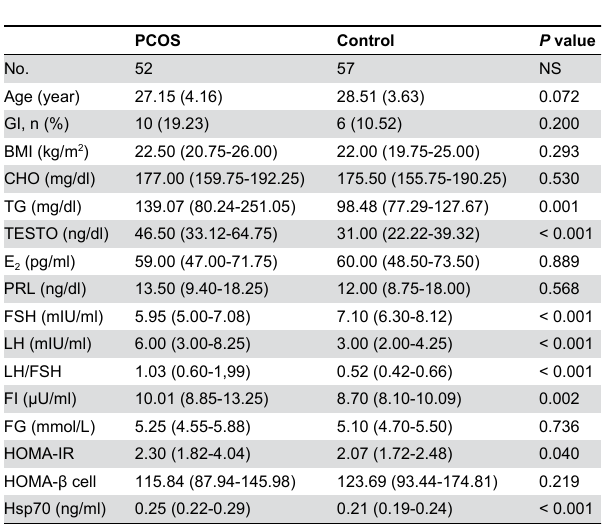
Table 1. A Comparison of Characteristics between PCOS Cases and